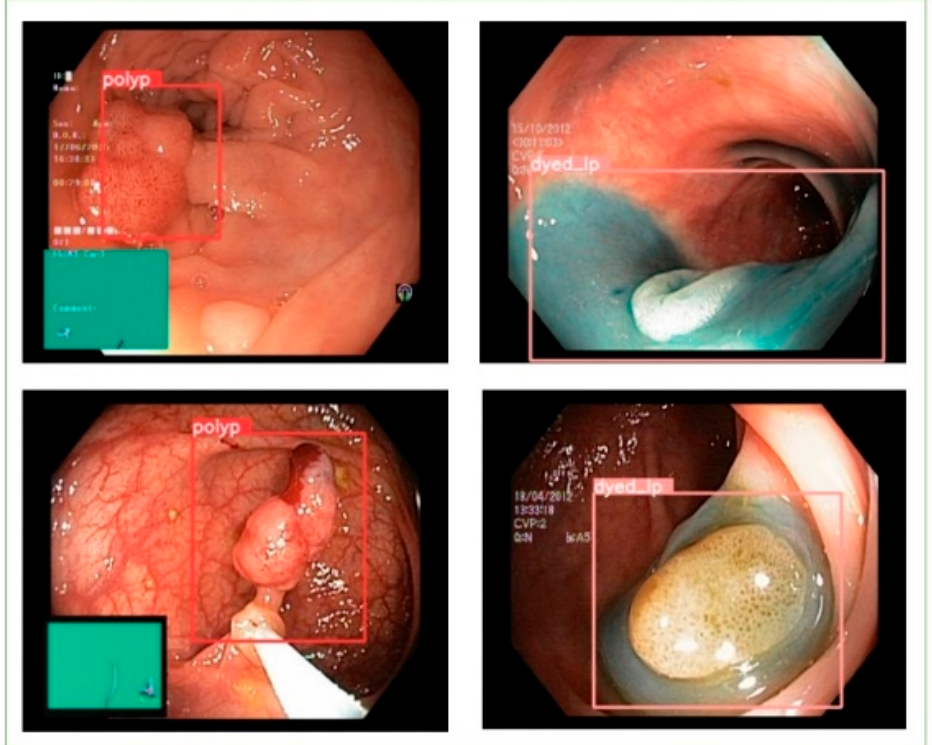
Figure 7. The detection and classification of the test image with our custom version.